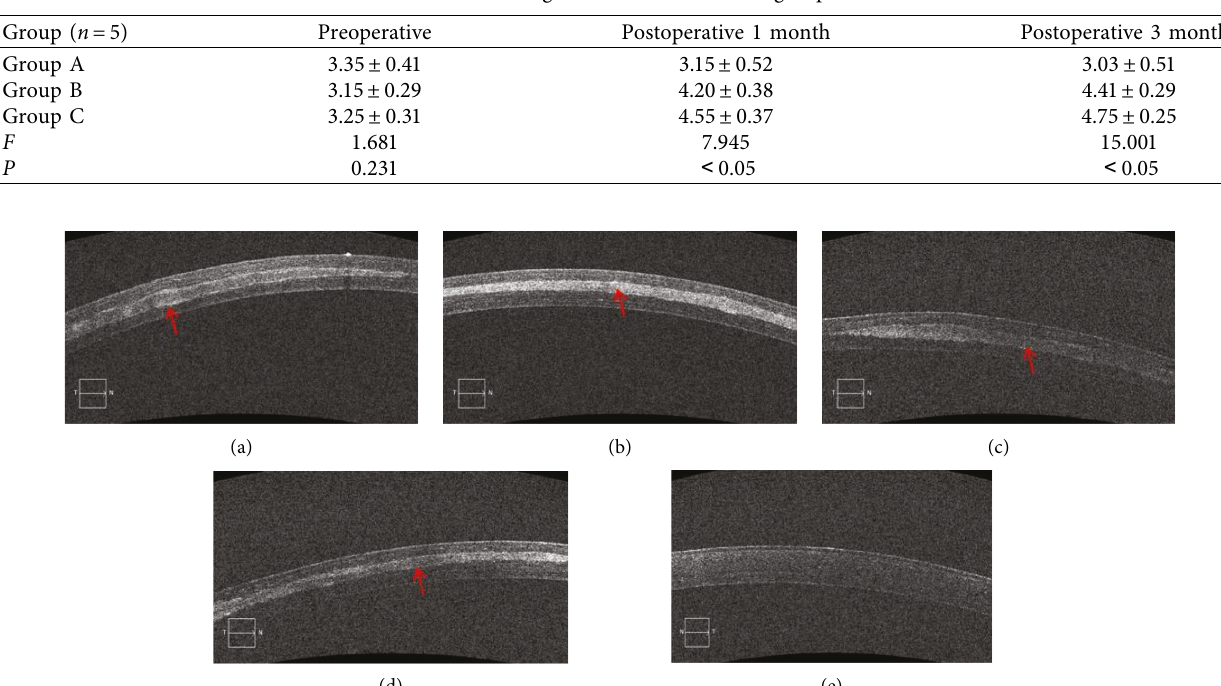
Figure 3: Postoperative OCT images in different groups. (a) One month after the operation, uneven surface and uneven thickness (red arrow) of the corneal stromal lens in group B. (b) Lens of group C showed flat surface, uniform thickness, and slightly enhanced lens development (red arrow). (c, d) Three months after the operation, the density of the lens decreased in group B and C (red arrow). (e) Control group.